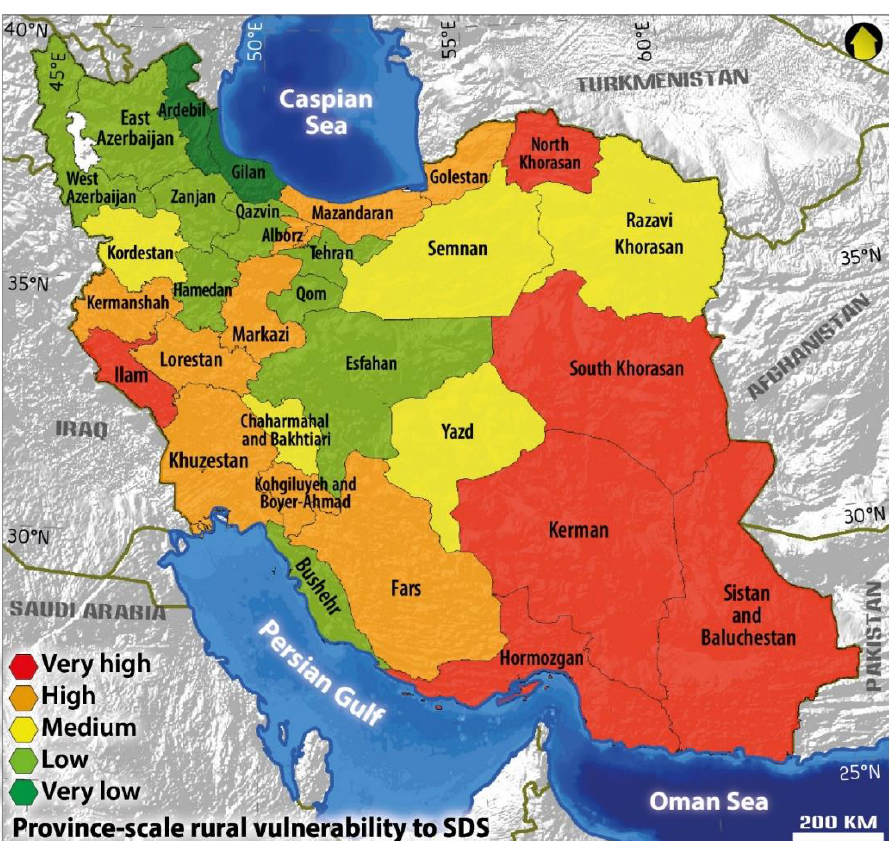
Figure 7. Provincial SDS vulnerability map for rural areas of Iran.